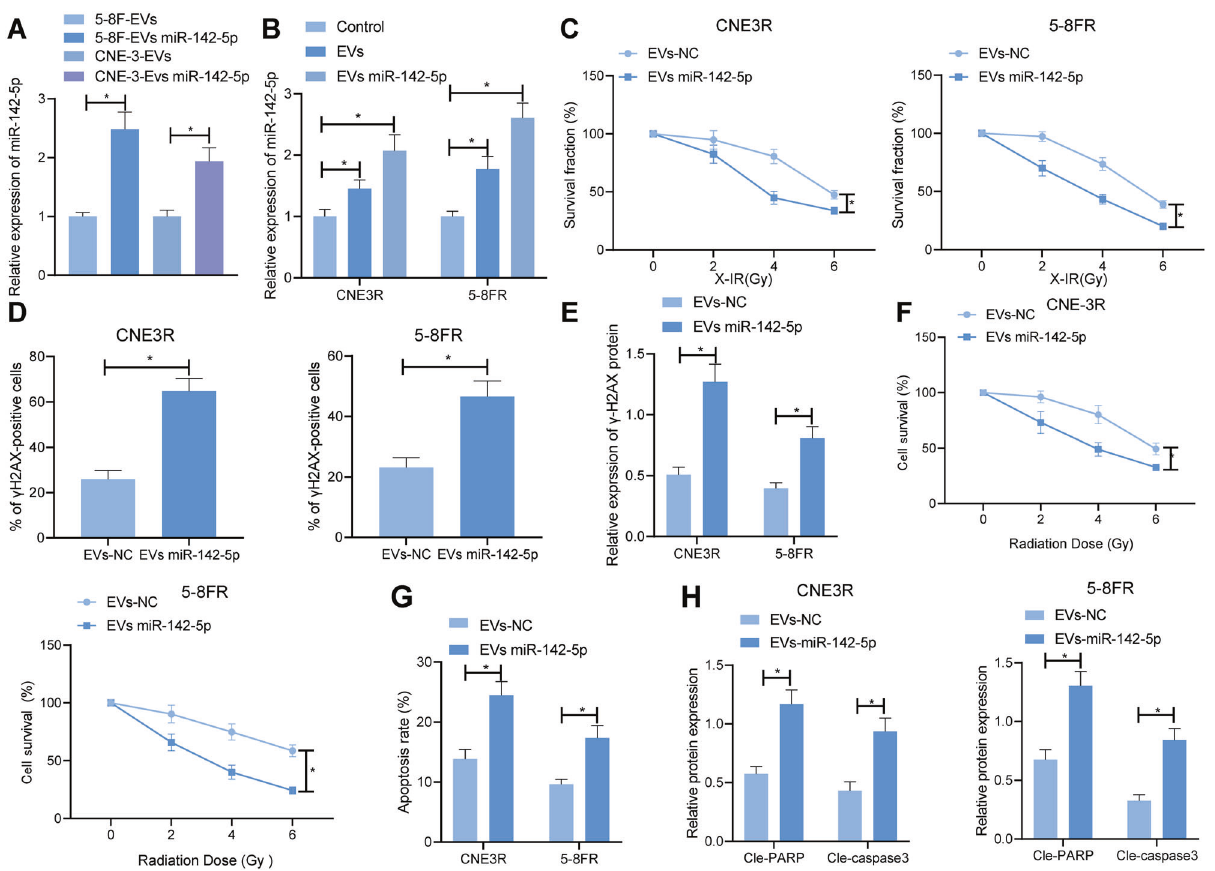
Fig. 4 EVs-miR-142-5p facilitates NPC cell radiosensitivity to repress proliferation and increase apoptosis of NPC cells. A The expression of miR-142-5p in EVs secreted by 5 – 8 F and CNE-3 cells assessed by RT-qPCR. B RT-qPCR to check the expression of miR-142-5p in 5-8FR and CNE- 3R cells after co-incubation with the EVs secreted by 5 – 8 F and CNE-3 cells. C Colony formation assay to detect the number of colonies formed by 5-8FR and CNE-3R cells under different doses of radiotherapy. D The effect of EVs-miR-142-5p on the expression of γ H2AX protein in 5-8FR and CNE-3R cells detected by immuno fl uorescence staining. E Western blot to detect the effect of EVs-miR-142-5p on the expression of γ H2AX protein in 5-8FR and CNE-3R cells. F MTS to determine the effect of EVs-miR-142-5p on the proliferation of 5-8FR and CNE-3R cells. G The effect of EVs-miR-142-5p on the apoptosis rate of 5-8FR and CNE-3R cells detected by fl ow cytometry. H Western blot to appraise the expression of apoptotic proteins in 5-8FR and CNE-3R cells with EVs-miR-142-5p. * p < 0.05. All experiments were repeated three